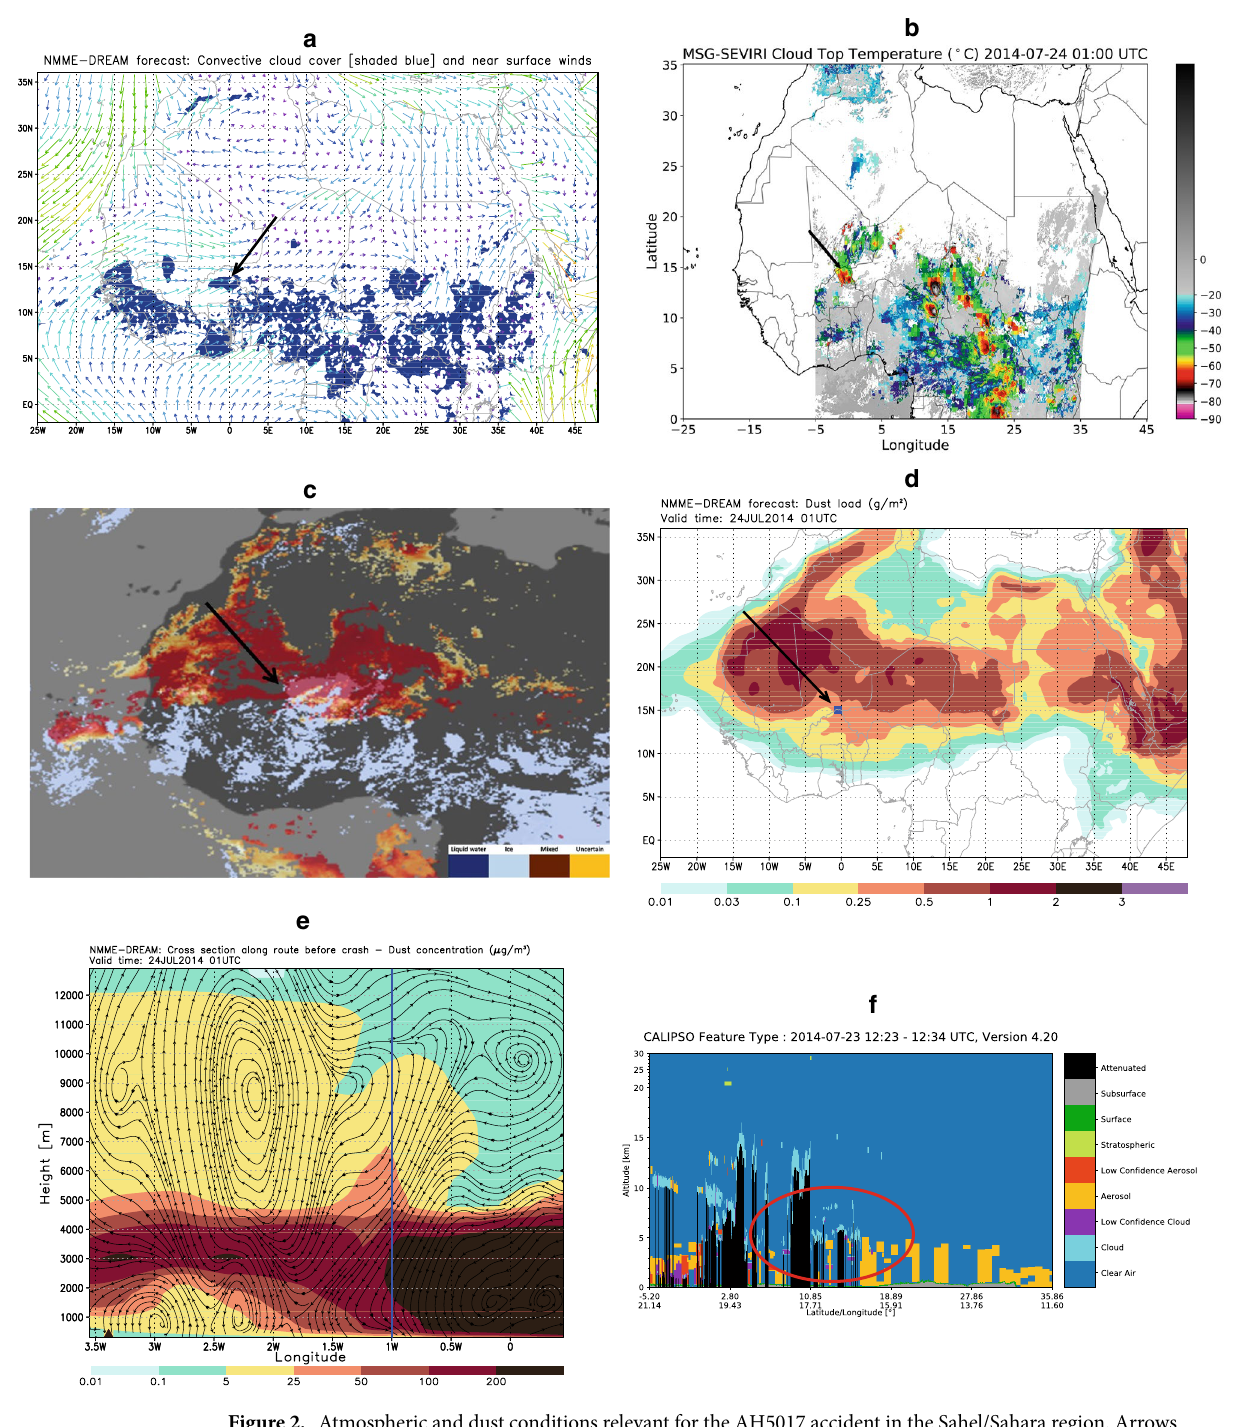
Figure 2. Atmospheric and dust conditions relevant for the AH5017 accident in the Sahel/Sahara region. Arrows and thick lines indicate location of the accident. ( A ) Model convective cloud cover (shaded) and the near-surface wind (colored arrows) at 01 UTC 24 July 2014 indicating the location of WAM characterized with wind convergence in the lower atmosphere. Moisture transported by SE wind generated unstable convection conditions in the region. ( B ) Cloud top temperatures observed by EUMETSAT MSG SEVIRI at 02 UTC 24 July 2014 identifying the presence of cumulonimbus clouds. ( C ) Ice cloud phase in NASA/MODIS satellite observation on 23 July 2014 showing a cold cloud system in the zone of the accident. ( D ) Vertically integrated dust concentration gm −2 at 01UTC 24 July 2014 − 3 ] and wind streamlines at 01 UTC 24 July 2014 in the vertical predicted by the model. ( E ) Dust concentration [ µ gm section crossing the atmosphere along the AH5017 flight. Dust was lifted by strong upward convection motion from the lower levels to the upper troposphere. ( F ) CALIPSO/CALIOP profile at 12:15 UTC 23 July 2014, 14 h before the accident (this was the closest time to the accident time in CALIPSO passes over the region) showing that there was already a layer of dust in the lower atmosphere and convective cold clouds at 9–10 km in the wider zone of the AH5017 accident. The red oval tick line shows that the wider region of the accident was characterized by presence of dust, convection and elevated cold